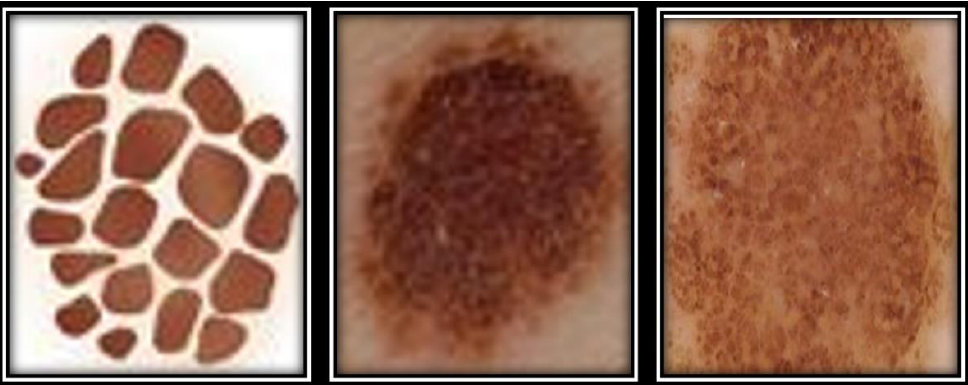
Figure 3. The atypical pigmented network.